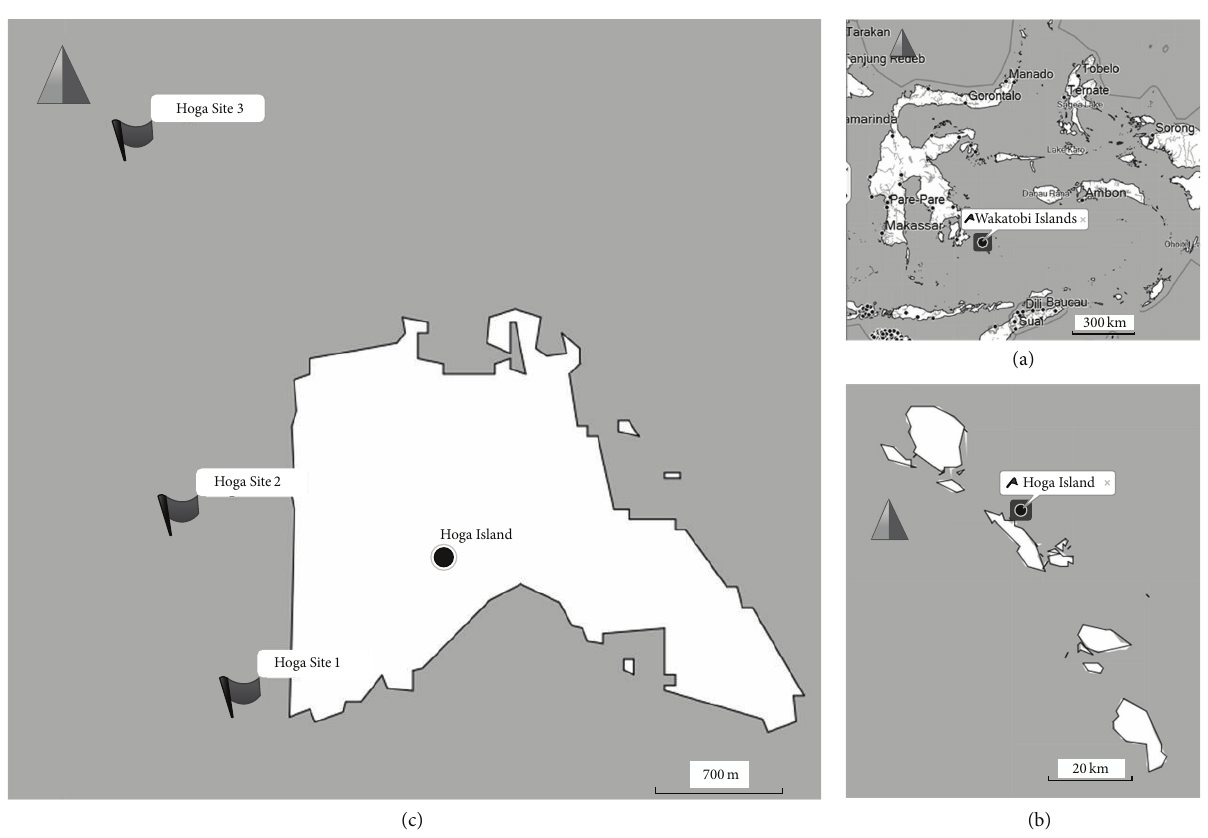
Figure 1: Sampling sites at Indonesian CTI region (a) at Wakatobi Islands (b), on the western side of Hoga Island